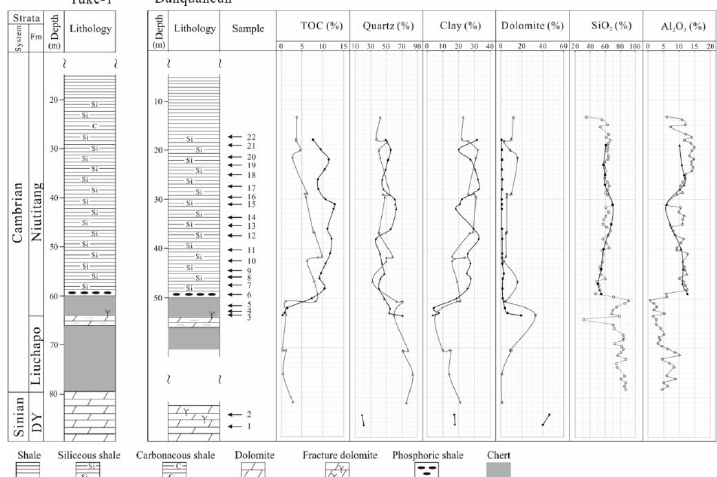
Figure 5. Lithological profile, sample location, total organic carbon content (TOC), quartz, clay, carbonate contents and major elements of Yuke-1 (YK-1) well (hollow circles, [32]; cross stars, [22] and the Danquancun section (solid circles). The lithology of the Danquancun section and YK-1 well is similar from bottom to top. DY = Dengying, Fm = Formation.